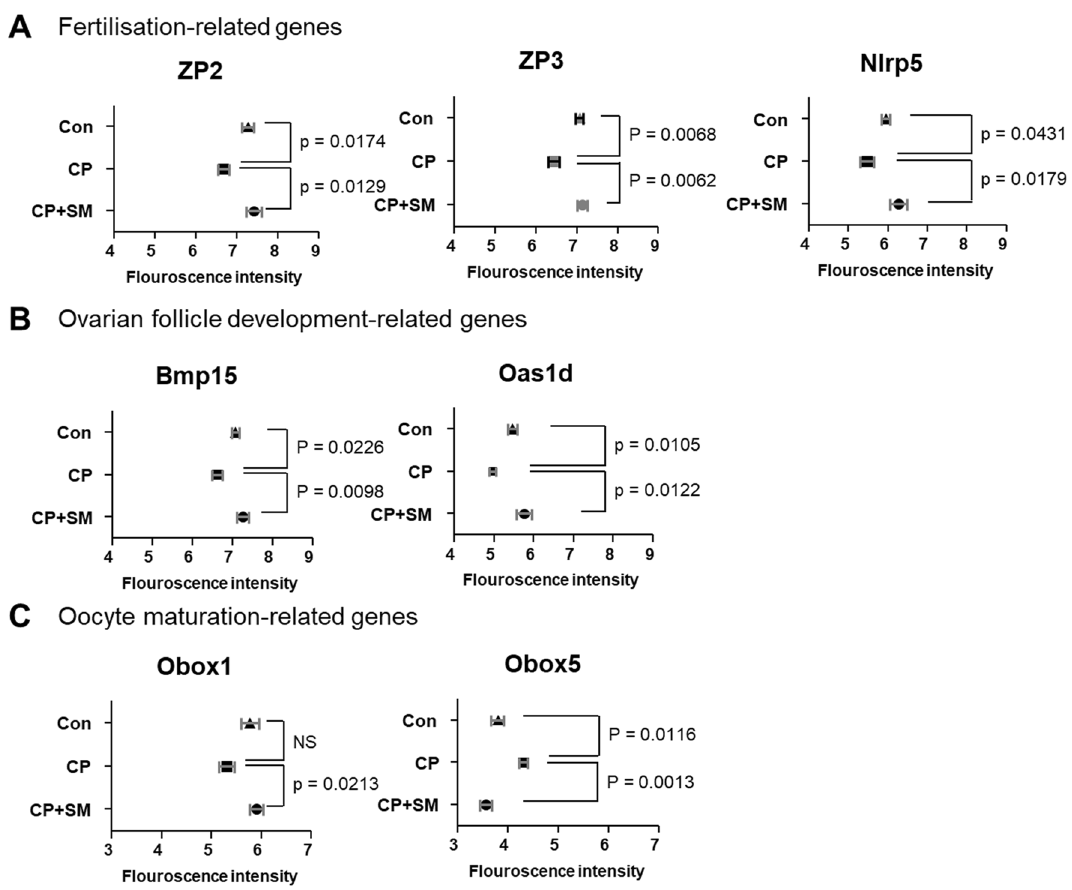
Figure 5. Differentially expressed mRNAs involved in ovarian function. Microarray fluorescence intensities indicate the expression levels of ( A ) Zp2 , Zp3 , and Nlrp5 genes, involved in fertilisation, ( B ) Bmp15 and Oas1d genes, involved in ovarian follicle development, and ( C ) Obox1 and Obox5 genes, involved in oocyte maturation, in ovaries of the Con, CP, and CP + SM mice. Statistical analysis was performed using the Student’s t -test. Con saline-treated control mice; CP cyclophosphamide-treated mice; CP + SM CP-treated mice orally administered